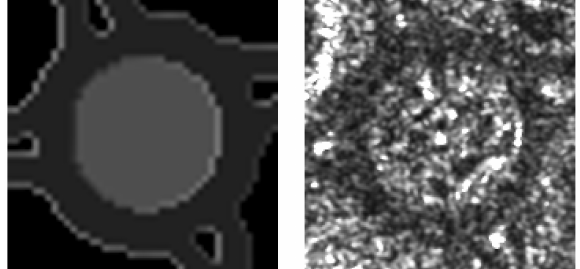
Figure 6. The roundabout template (left), which is generated from the first roundabout of the WorldView- 2 image, and the cor- responding area in the TerraSAR-X image with the highest NCC value (right). The corresponding NCC can be seen in Figure 5.